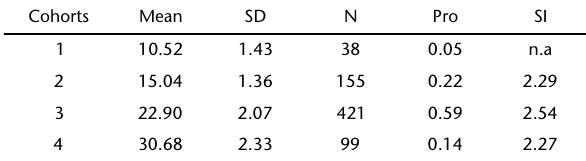
Table III. Mean, Standard deviation (SD), Number of individuals (N), proportion of individual (Pro), and separation index (SI) of each cohort using the Bhattacharya method for population of H. marginatus from 2002. Cohorts